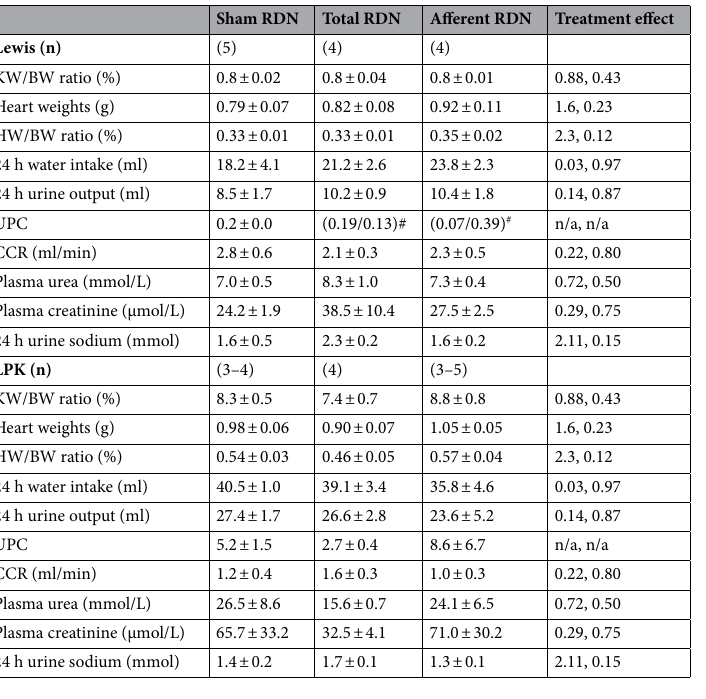
Table 4. Morphometric and biochemical parameters at 10 weeks of age. RDN, renal denervation. KW/BW, kidney weight/body weight. HW/BW, heart weight/body weight. UPC, urine protein to creatinine ratio. CCR, creatinine clearance rate. Data is expressed as the mean ± SEM. # In the Lewis, 2 animals in the total RDN and 2 animals in the afferent RDN group had urine protein levels below the level of detection. Thus the values for UPC are provided as each animals individual result and no statistical analysis was undertaken. Treatment effect is provided as F statistic and P value, indicating overall treatment effect determined using two-way ANOVA with strain and treatment as the two